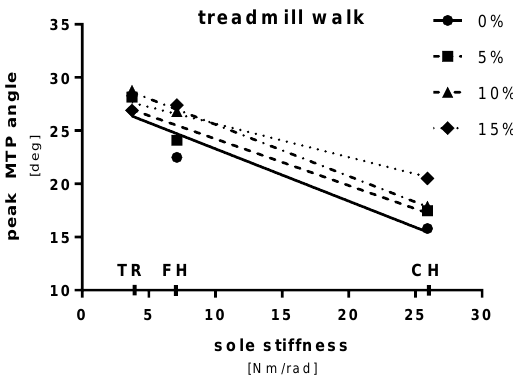
Figure 4. Results of the first campaign of data acquisition: peak MTP angle versus shoe sole stiffness parametric in the terrain slope for the walking